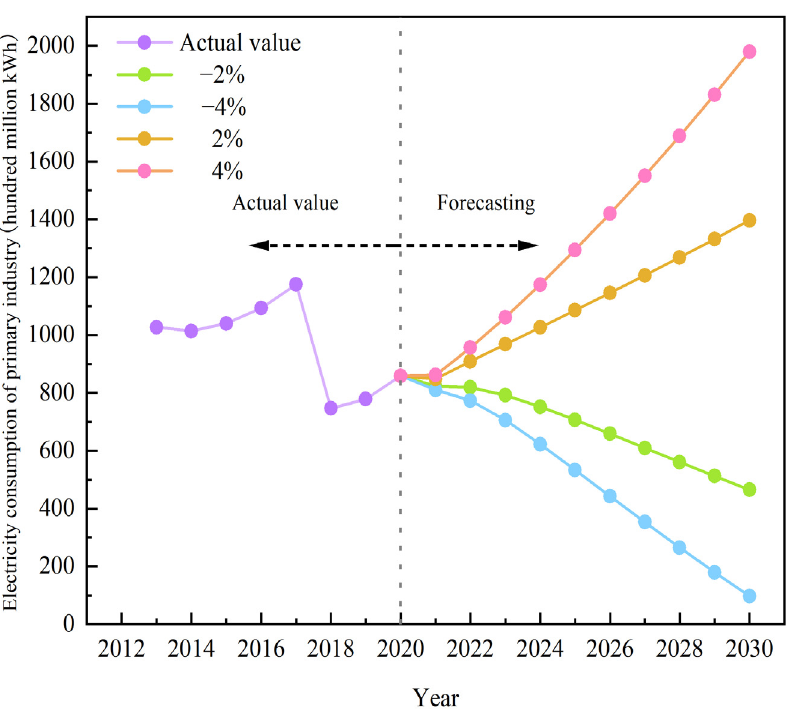
Figure 7. Power consumption forecast results of China’s primary